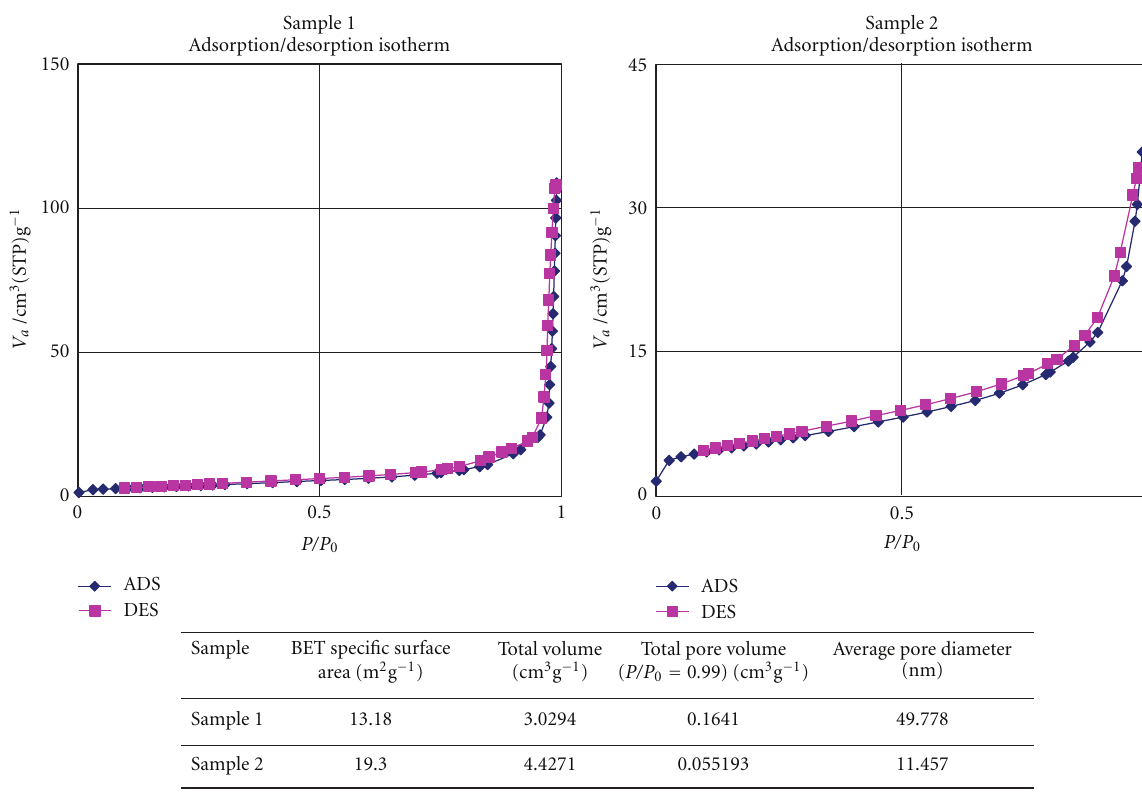
Figure 4: The adsorption-desorption isotherm curves of N 2 at 77 K on the synthesized samples 1 and 2.